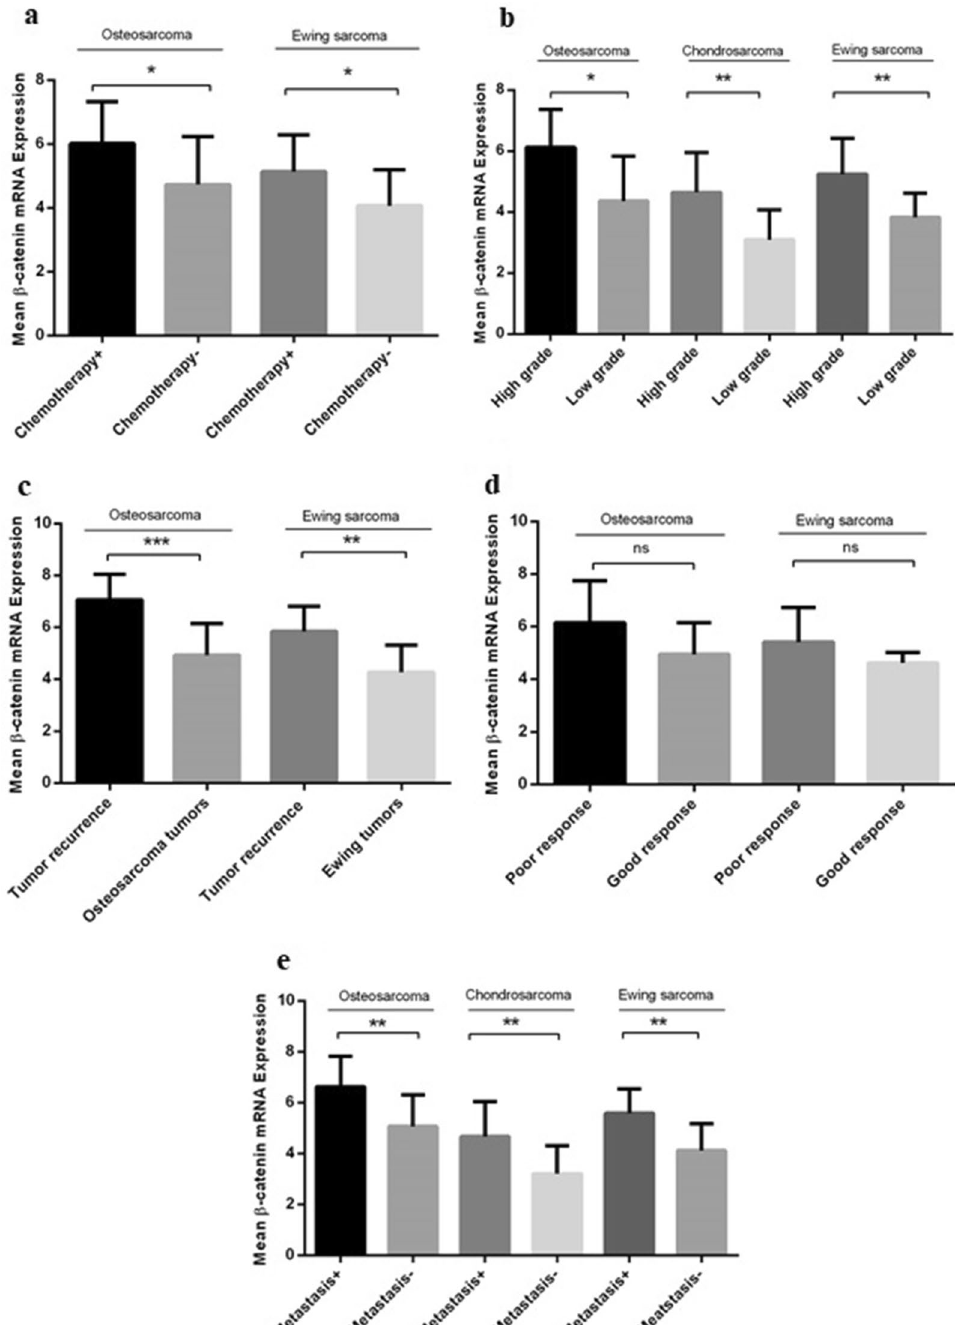
Figure 2. The β-catenin gene expression in malignant bone tumors with different tumor grades, metastasis, recurrent and chemotherapy status. The β-catenin mRNA expression level was evaluated in different types of osteosarcoma, chondrosarcoma, and Ewing’s Sarcoma. An increase in the mRNA expression level of β-catenin was observed in chemotherapy-received osteosarcoma and Ewing’s Sarcoma tumors ( a ), osteosarcoma, chondrosarcoma, and Ewing’s Sarcoma high-grade tumors ( b ), recurrent osteosarcoma and Ewing’s Sarcoma tumors ( c ), osteosarcoma and Ewing’s Sarcoma tumors with poor response to the chemotherapy ( d ), and osteosarcoma, chondrosarcoma, and Ewing’s Sarcoma metastatic tumors in each malignant group ( e ). The comparative CT (2 −ΔCt ) method was applied for gene expression analysis. Kolmogorov–Smirnov analysis showed normal distribution of data therefore t-student test was used to evaluate the difference in the expression level of β-catenin between groups. The statistical differences between groups are shown as asterisk (*P < 0.05, **P < 0.01, ***P <